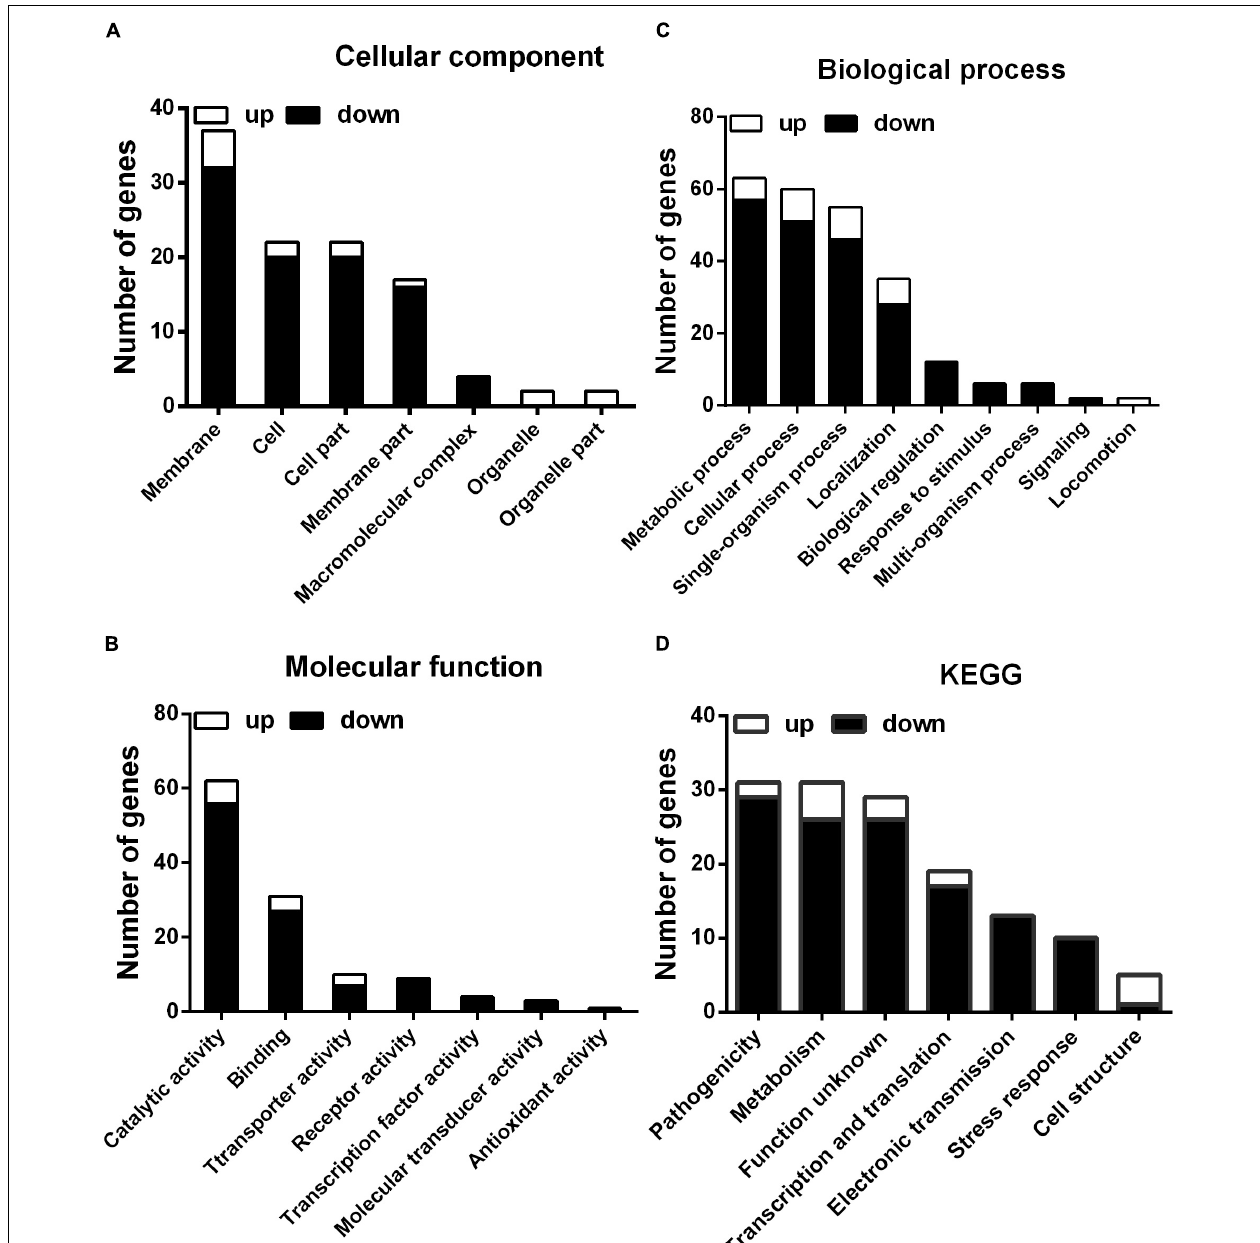
FIGURE 6 | Classification of differentially expressed genes by gene ontology (GO) enrichment and cellular mapping. (A) Number of differentially expressed genes. (B) Cellular component classifications. (C) Molecular function. (D) Biological process.